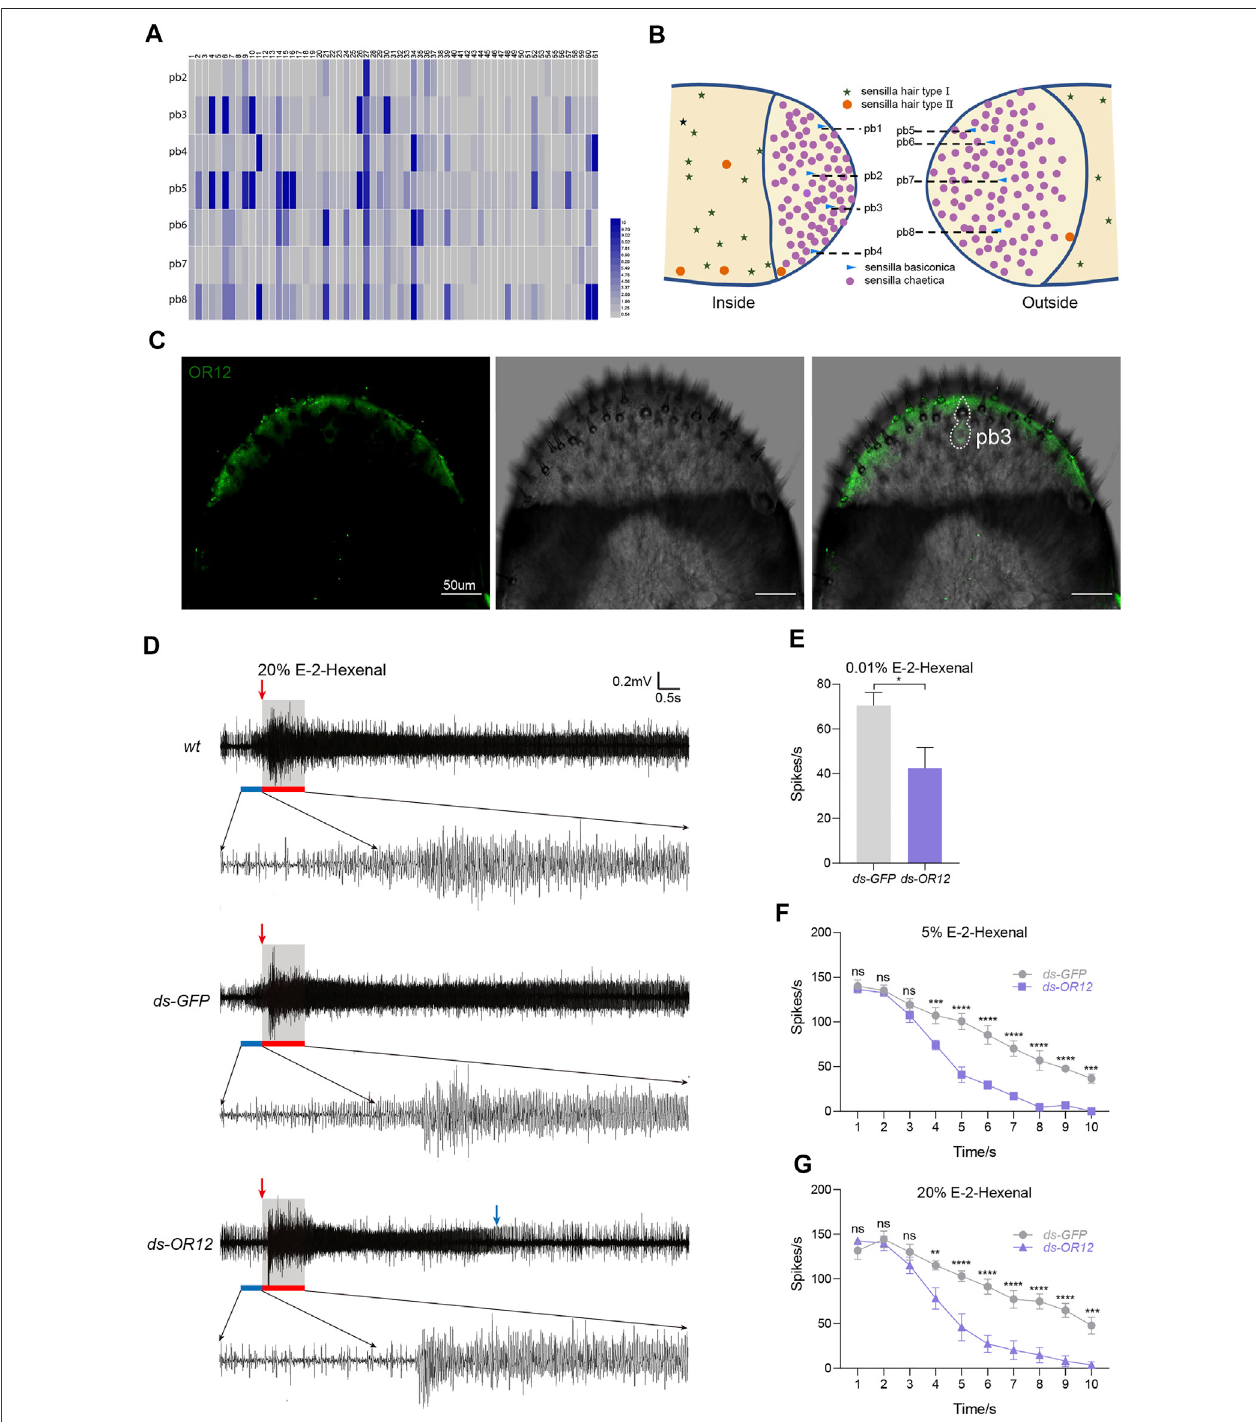
FIGURE 5 | OR12 tunes the response to E-2-hexenal in olfactory neurons in a basiconic sensillum. (A) Coding of odors by the basiconic sensilla on the maxillary palp. The top numbers (1 – 61) represent paraf fi n oil and 60 characteristic odors used for stimulation. On the left, pb2-pb8 are 7 subtypes of basiconic sensilla on the maxillary palp. The color code from blue to red indicates the recovery time from 0 to 10 s. The recovery time is the duration of continuous excitation of neurons in the basiconic sensilla after stimulation. n = 6 – 7 palps per odor. (B) Schematic diagram of the distributions of the basiconic sensilla on the maxillary palp. (C) Whole- mount fl uorescence insitu hybridization(WM-FISH)usingOR12-speci fi cDIG-labeledantisenseRNAprobes.CellsbearingOR12werevisualizedbygreen fl uorescence. ThewhitedashedlinemarksneuronsexpressingOR12andthecorrespondingpalpbasiconicsensillum(pb3).Scalebars:50 µm. (D)